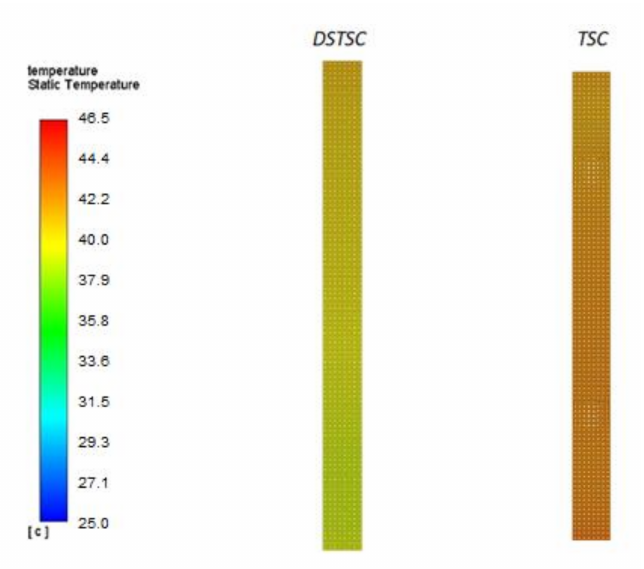
Figure 6. Temperature distribution on the perforated absorber plate for the DSTSC ( left ) and TSC ( right ) at an airflow rate of 500 m 3